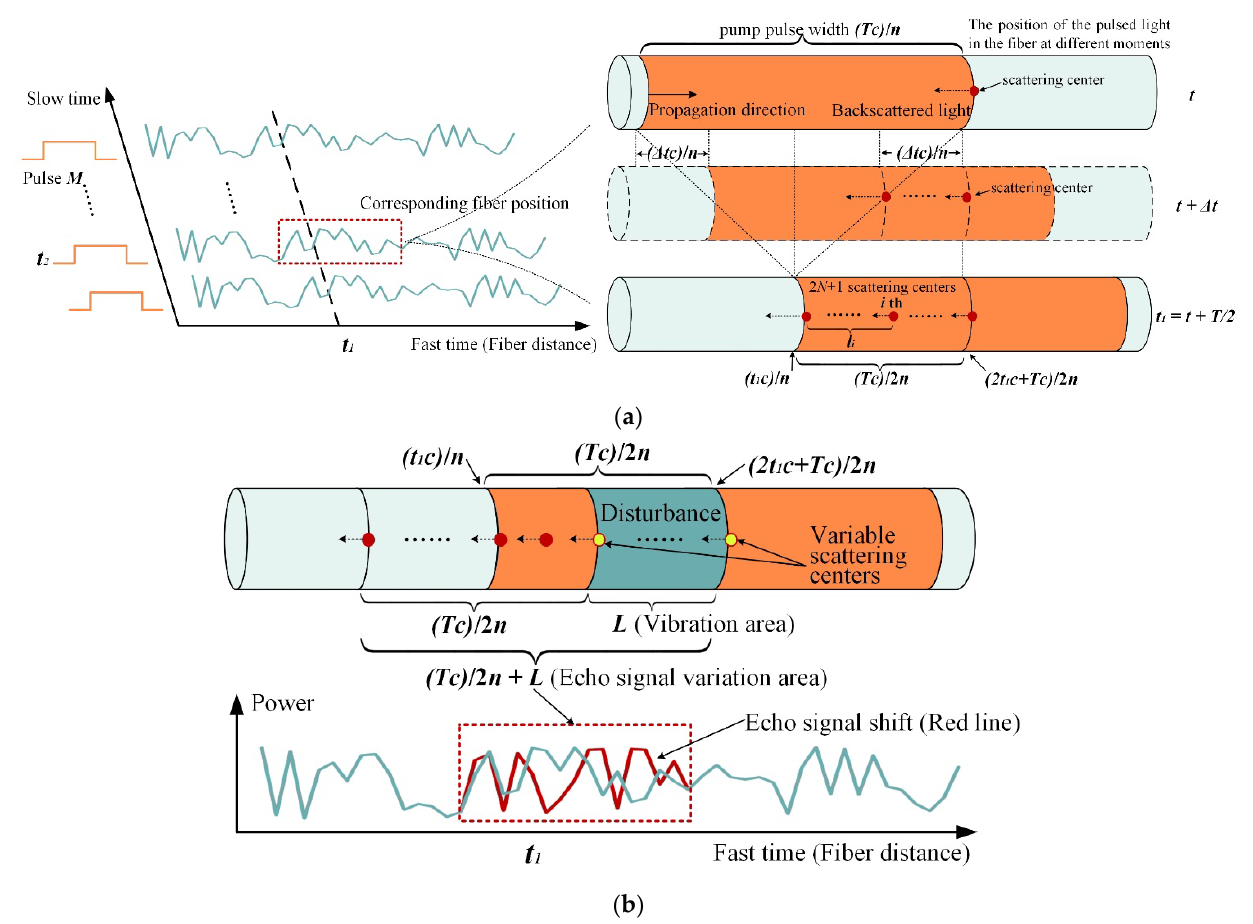
Figure 2. Φ -OTDR backscattering principle: ( a ) Superposition principle of backscattered light from all scattering centers within a half-light pulse width; ( b ) The effect of vibration on the echo signal, where the variable scattering center is marked in yellow.